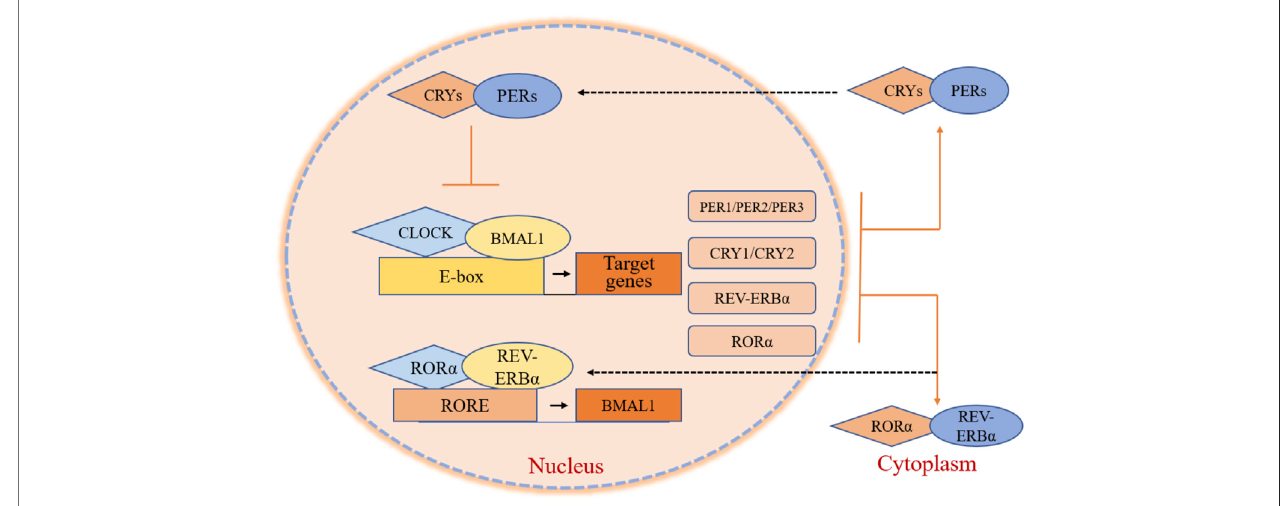
FIGURE 1 | Core clock gene organization in circadian clocks. BMAL1 and CLOCK are transcription factors that contain two helix-loop-helix domains and bind E-boxelementsinthe PER , CRY , REV-ERB α ,and ROR α genes,in fl uencingpositivelyoncircadiantranscription. PER and CRY formheterodimers,interactingwithcasein kinase I ε (CKI ε ) and translating into the nucleus. These two genes negatively mediate BMAL1/CLOCK -driven transcription. ROR α and REV-ERB α activate and repress the transcription of BMAL1 through their competitive action on response elements (ROREs) on the BMAL1 promoter.